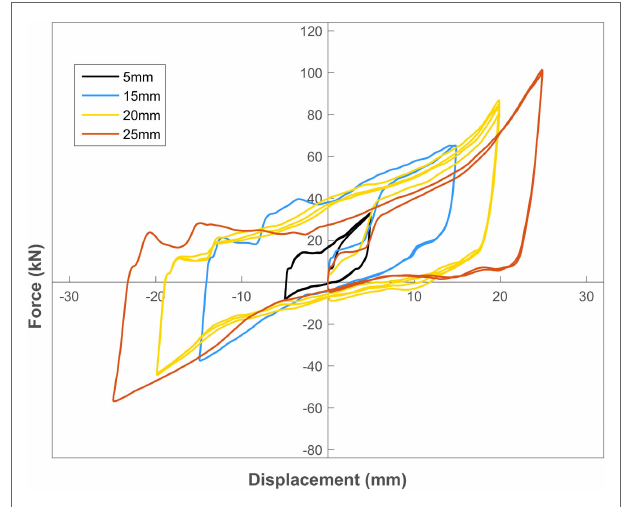
FigUre 7 | hysteresis loop under 100% strain for two laminated rubber blocks